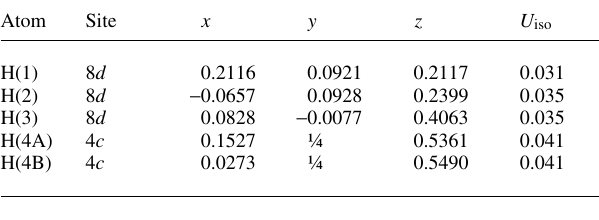
Table 3. Atomic coordinates and displacement parameters (in Å 2 )